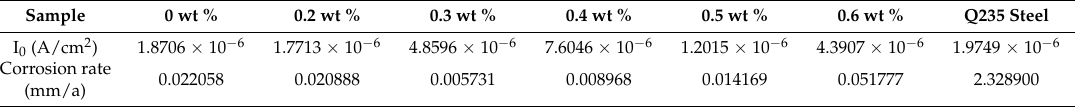
Figure 3. Polarization curves of different MWCNTs/WPU conductive coatings. Table 2. The corrosion current density and corrosion rate of MWCNTs/WPU conductive coating.